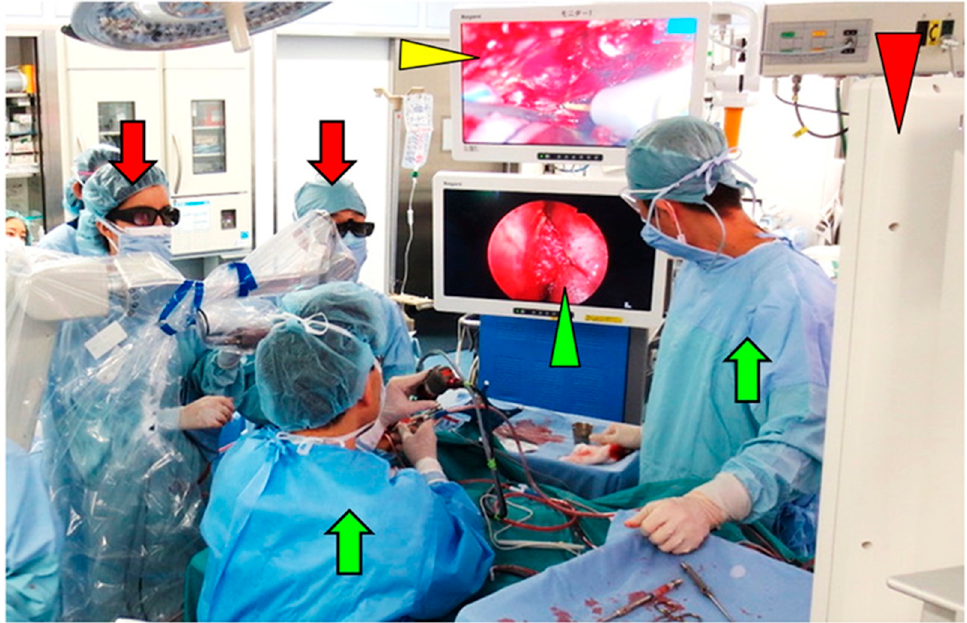
Figure 6. Intraoperative photograph showing two teams simultaneously performing transcranial and transnasal procedures during anterior craniofacial resection. Red arrows: transcranial team, green arrows: transnasal team, red arrowhead: display monitor for the transcranial team, green arrowhead: intranasal surgical field on the display monitor for the transnasal team, yellow arrowhead: intracranial surgical field on the display monitor for the transnasal team.